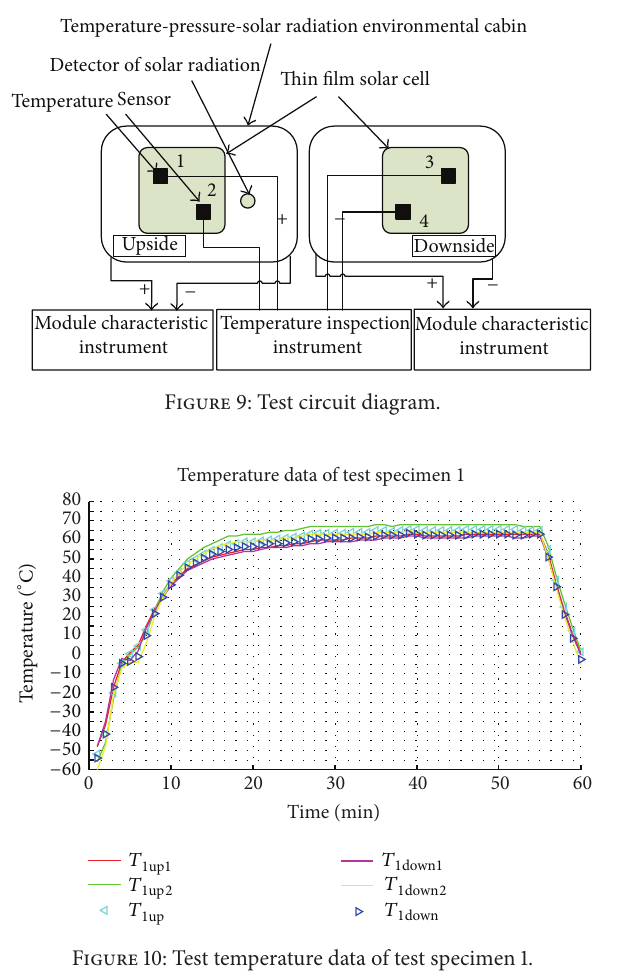
Figure 13: Simulation temperature of each layer.